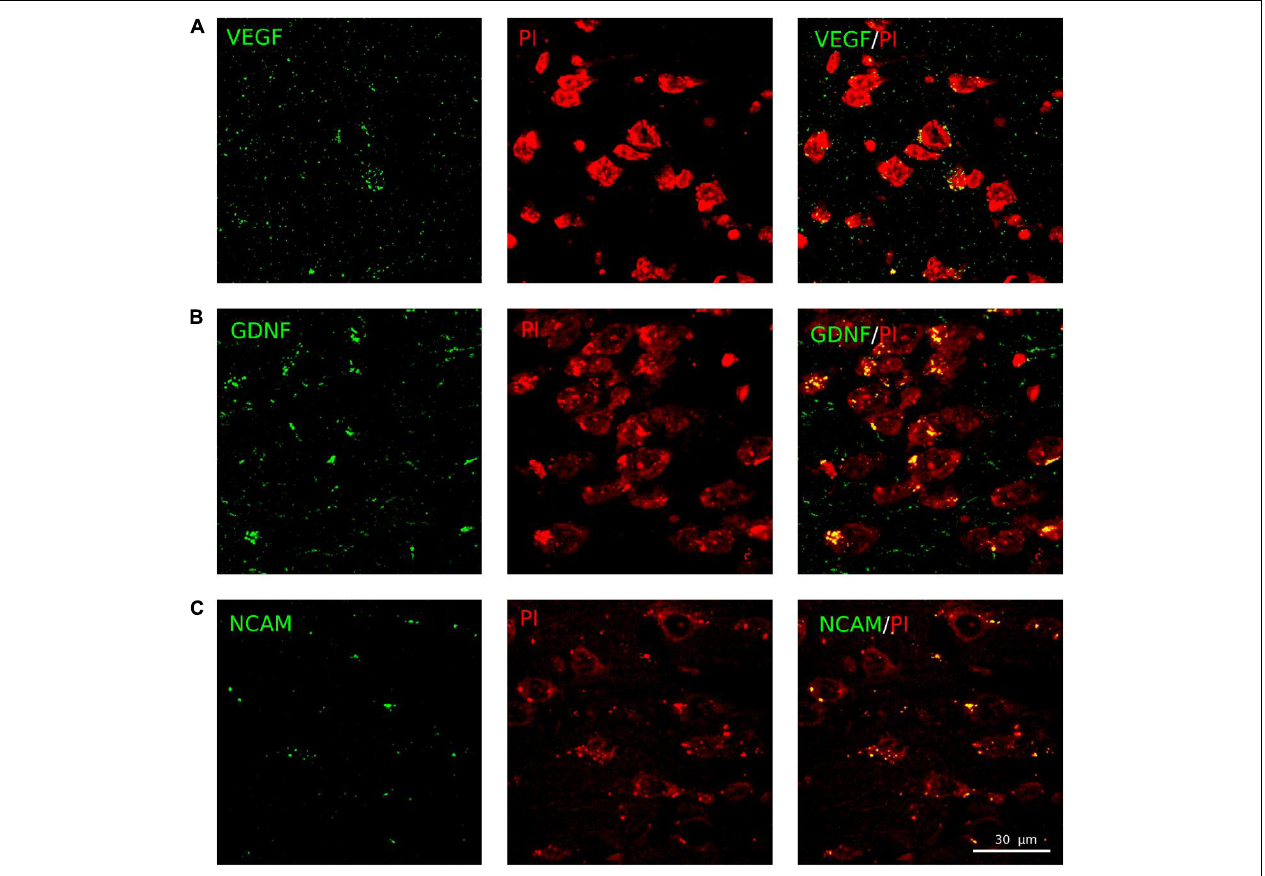
FIGURE 6 | Ad5-VEGF, Ad5-GDNF, and Ad5-NCAM transduction into the brain cortex cells. Immunofluorescent staining (green fluorescence) of the recombinant VEGF (A) , GDNF (B) , and NCAM (C) at 21 days after intrathecal injection of mixture of three adenoviral vectors carrying corresponding genes. Brain cortex cells were counterstained with PI. Scale bar = 30 µ